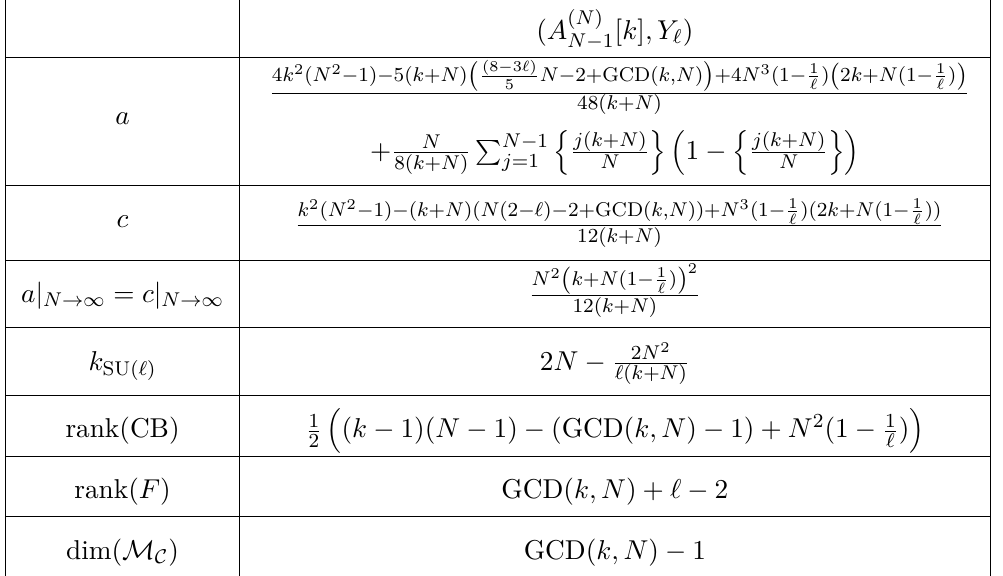
Table 1. The properties of the ( A N − 1 [ k ] ( N ) , Y ‘ ) theories that arise from N M5-branes wrapping a sphere with one irregular puncture of type A ( N ) [ k ] , and one regular puncture whose Young diagram N − 1 consists of ‘ columns and N/‘ rows. Here { x } = x − b x c denotes the fractional part. The case ‘ = 1 yields a “non-puncture” on the sphere, and these reduce to the class ( A N − 1 , A k − 1 ) . The case ‘ = N yields the maximal regular puncture with associated SU( N ) flavor symmetry. To compute the large- N scaling we assume that k is of order N . The dimension of the conformal manifold is reduced according to (4.9) for special values of k